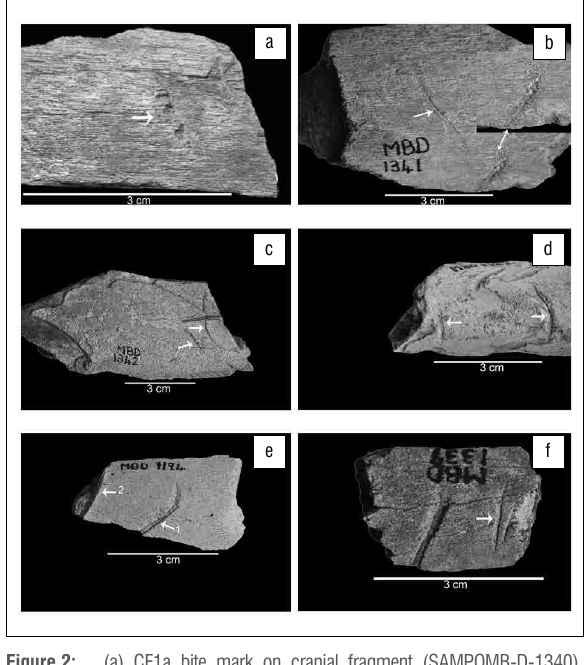
Figure 2: (a) CF1a bite mark on cranial fragment (SAMPQMB-D-1340). (b) Two CF1a bite marks on cranial fragment (SAMPQMB-D-1341) (inset close-up of second). (c) CF1a bite mark on a cranial fragment (SAMPQMB-D-1342) (arrowed). (d) CF2 bite mark on mandible fragment SAMPQMB-D-1182 (arrow). (e) CF2 bite marks on cranial fragment (SAMPQMB-D-1194) (arrow 1 and 2). (f) Two CF2 bite marks on the lateral surface of the cranial fragment (SAMPQMB-D-1339)